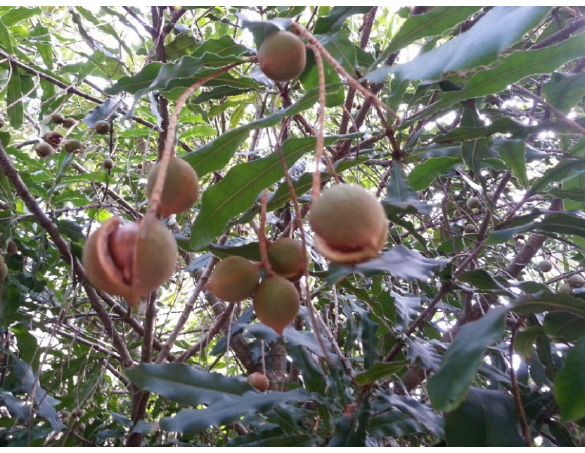
Figure 1. Macadamia tetraphylla nuts.